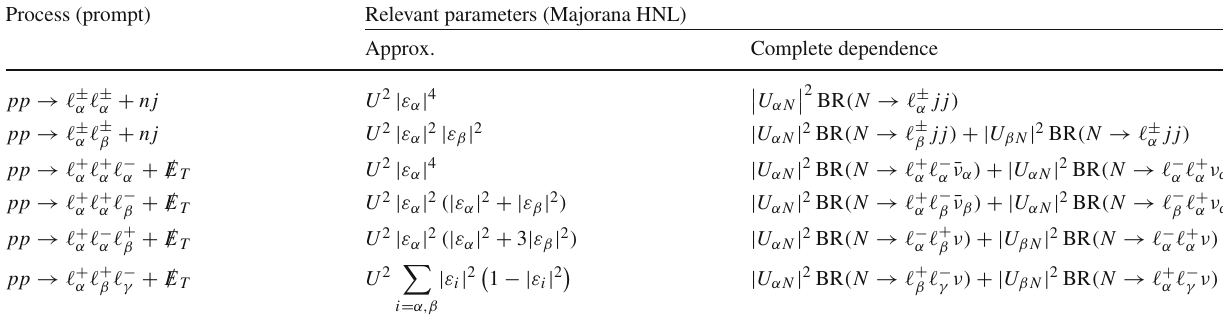
Table 2 Summary table for generic flavour dependences of dilpeton and trilepton channels at the LHC assuming a single Majorana HNL with generic mixing patterns. Flavour indices are to be understood